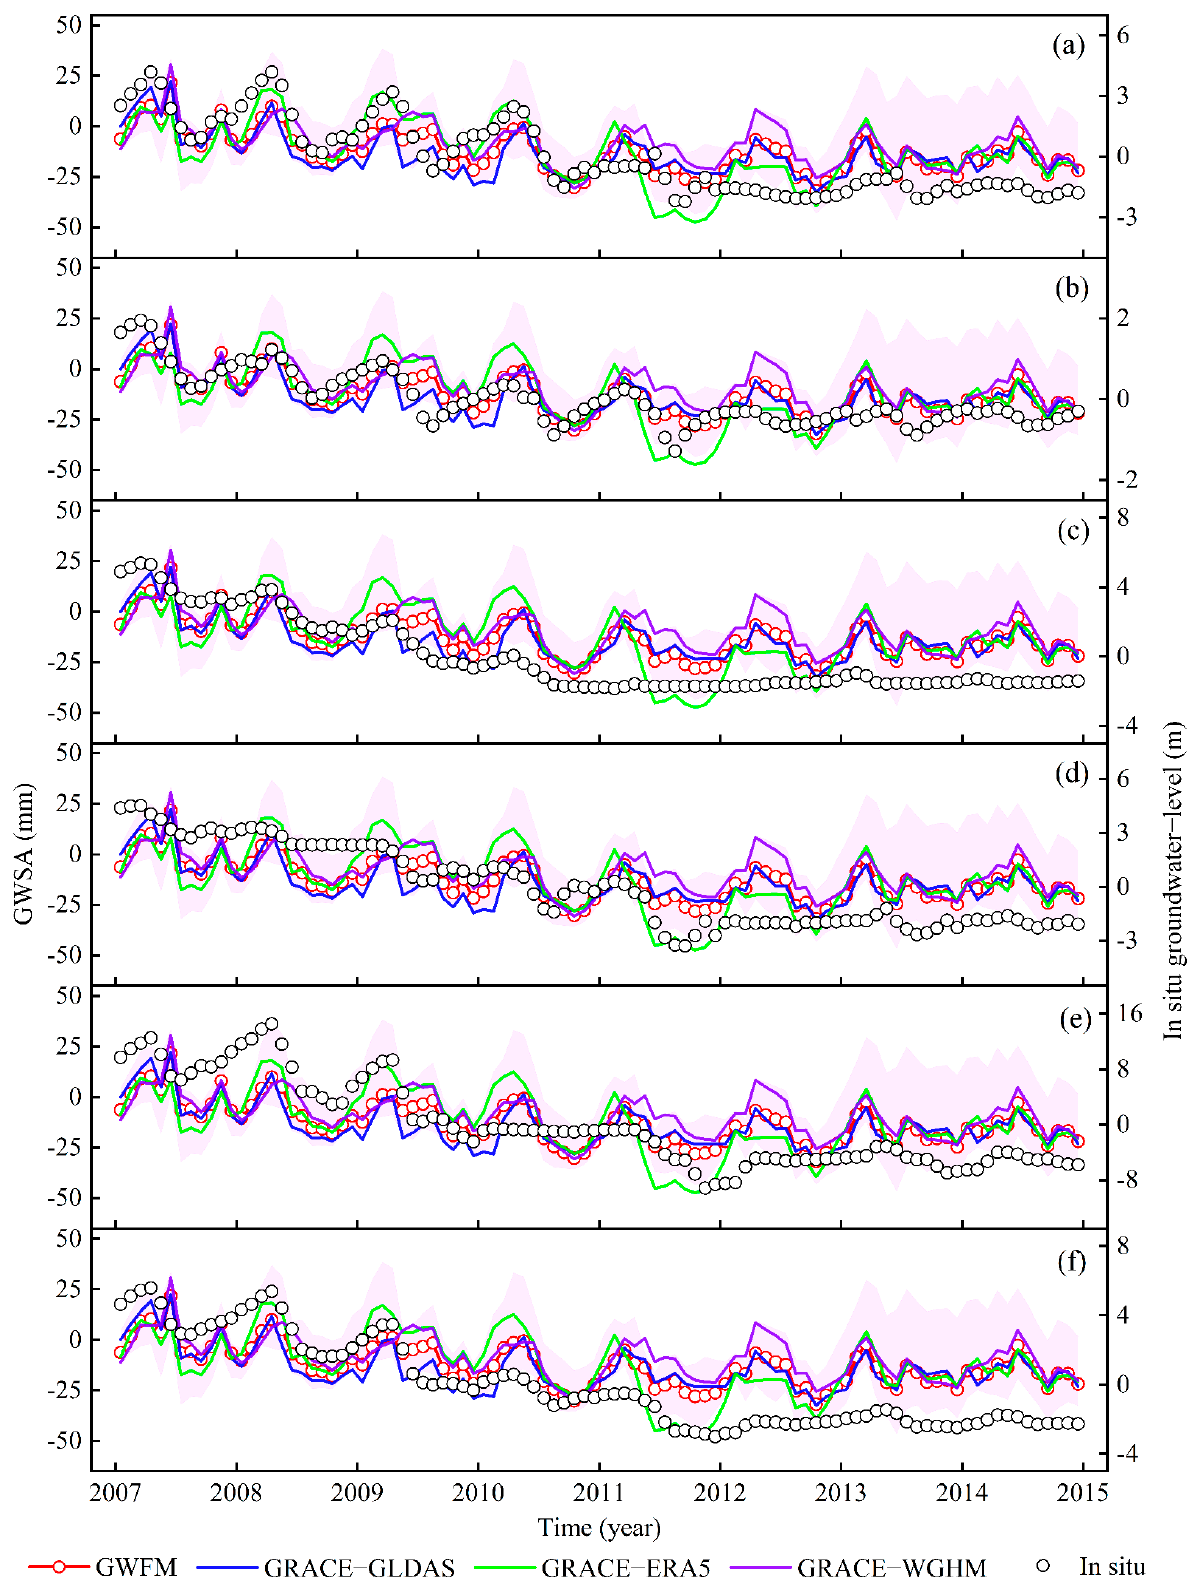
Figure 4. Comparison of GWSA from GRACE − GLDAS, GRACE − ERA5, GRACE − WGHM, and GWFM estimates with in situ groundwater-level measurements after setting the lag time. ( a ) S1; ( b ) S2; ( c ) S3; ( d ) S4; ( e ) S5; ( f ) average of S1–S5.